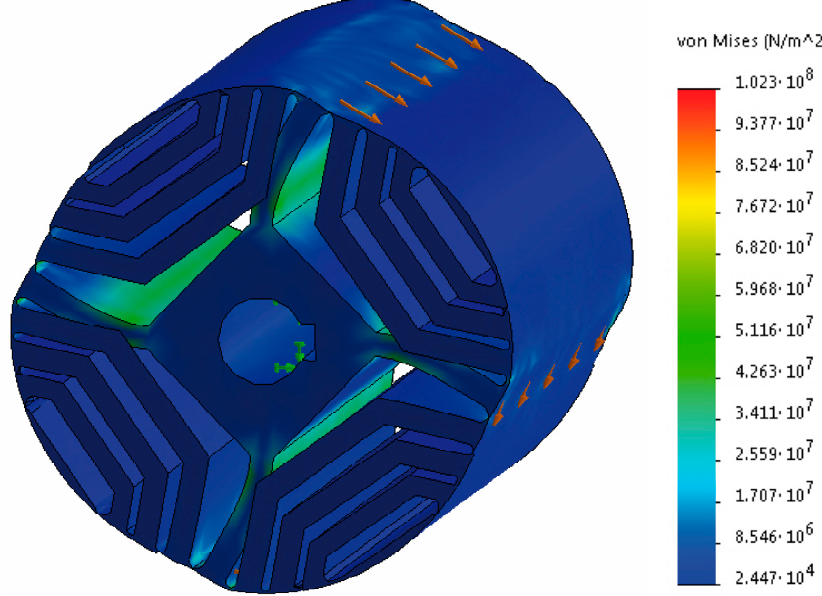
Figure 4. The distribution of mechanical stresses under torque.